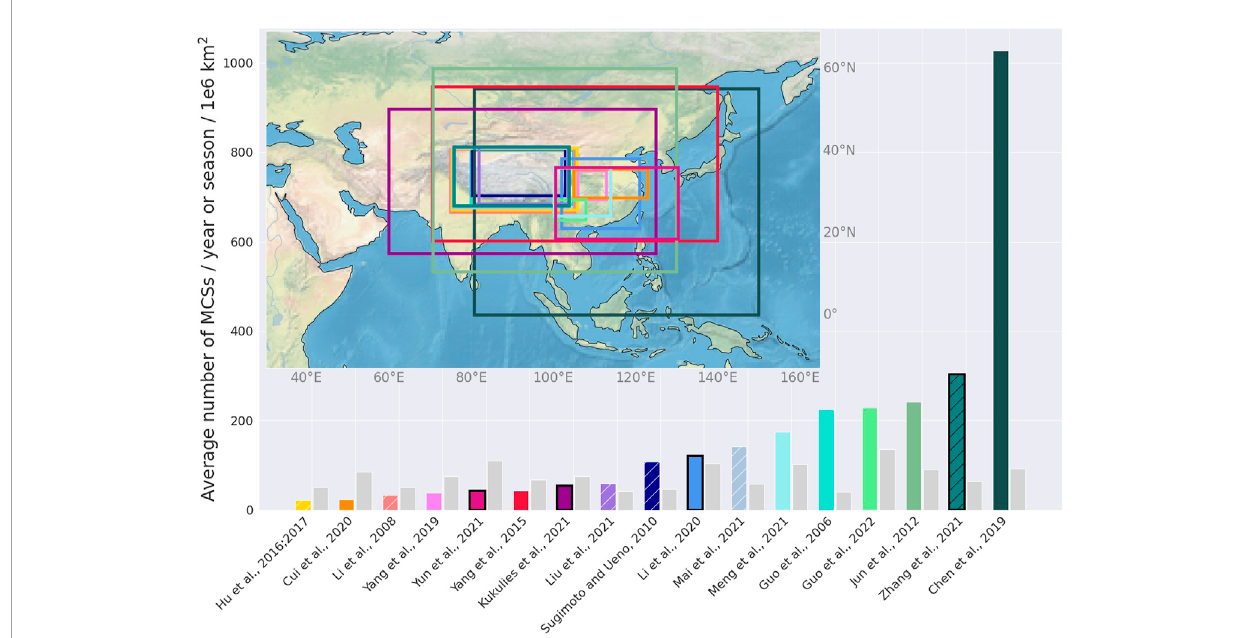
FIGURE 3 Overview of average MCS frequencies as found by different regional studies. The color-coded domains in the map correspond to the extent that was used for MCS tracking in the studies with the same color in the bar plot. Hatched bars mark studies that have focused on the TP in contrast to studies that have included or focused on the downstream regions. The bars with black edges denote the studies that have included precipitation as a criterion in their tracking, in contrast to studies that have used brightness temperatures only. The gray bars are from the global MCS tracking dataset from Feng et al. (2021b) matched to the same domain, time periods, and season to each of the regional studies. Note that, for a fair comparison, annual MCS frequencies have been normalized by the area of the tracking domain, so the average number of detected MCSs refers to the same area